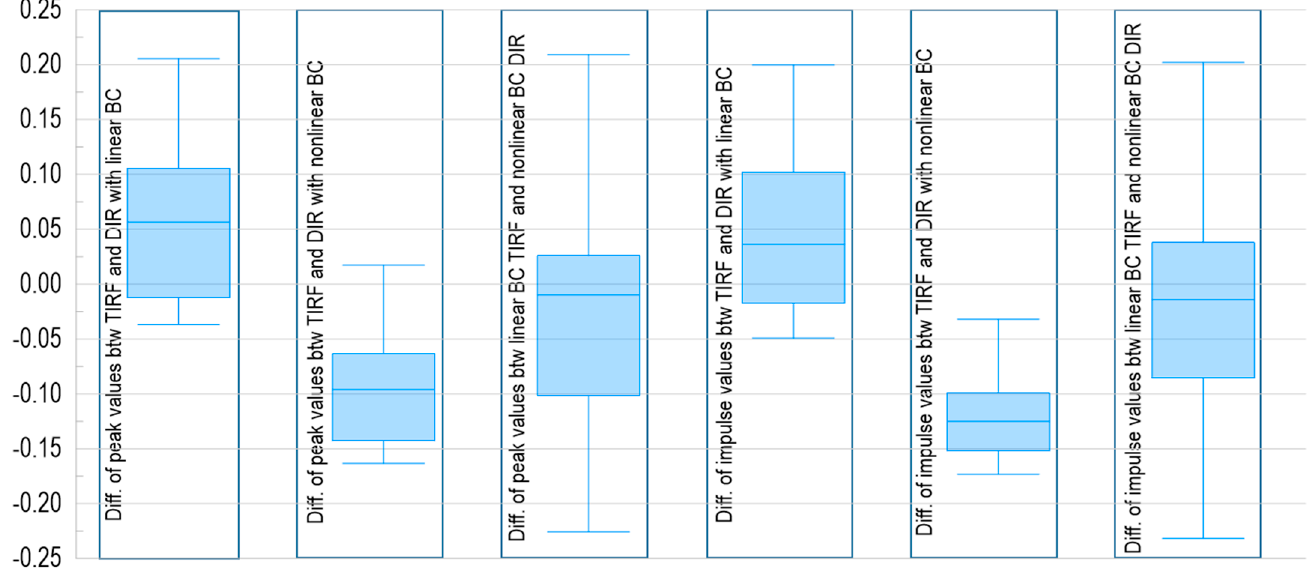
Figure 22. Box and whisker plots for the difference in the peak bending stresses and impulse values using TIRF and